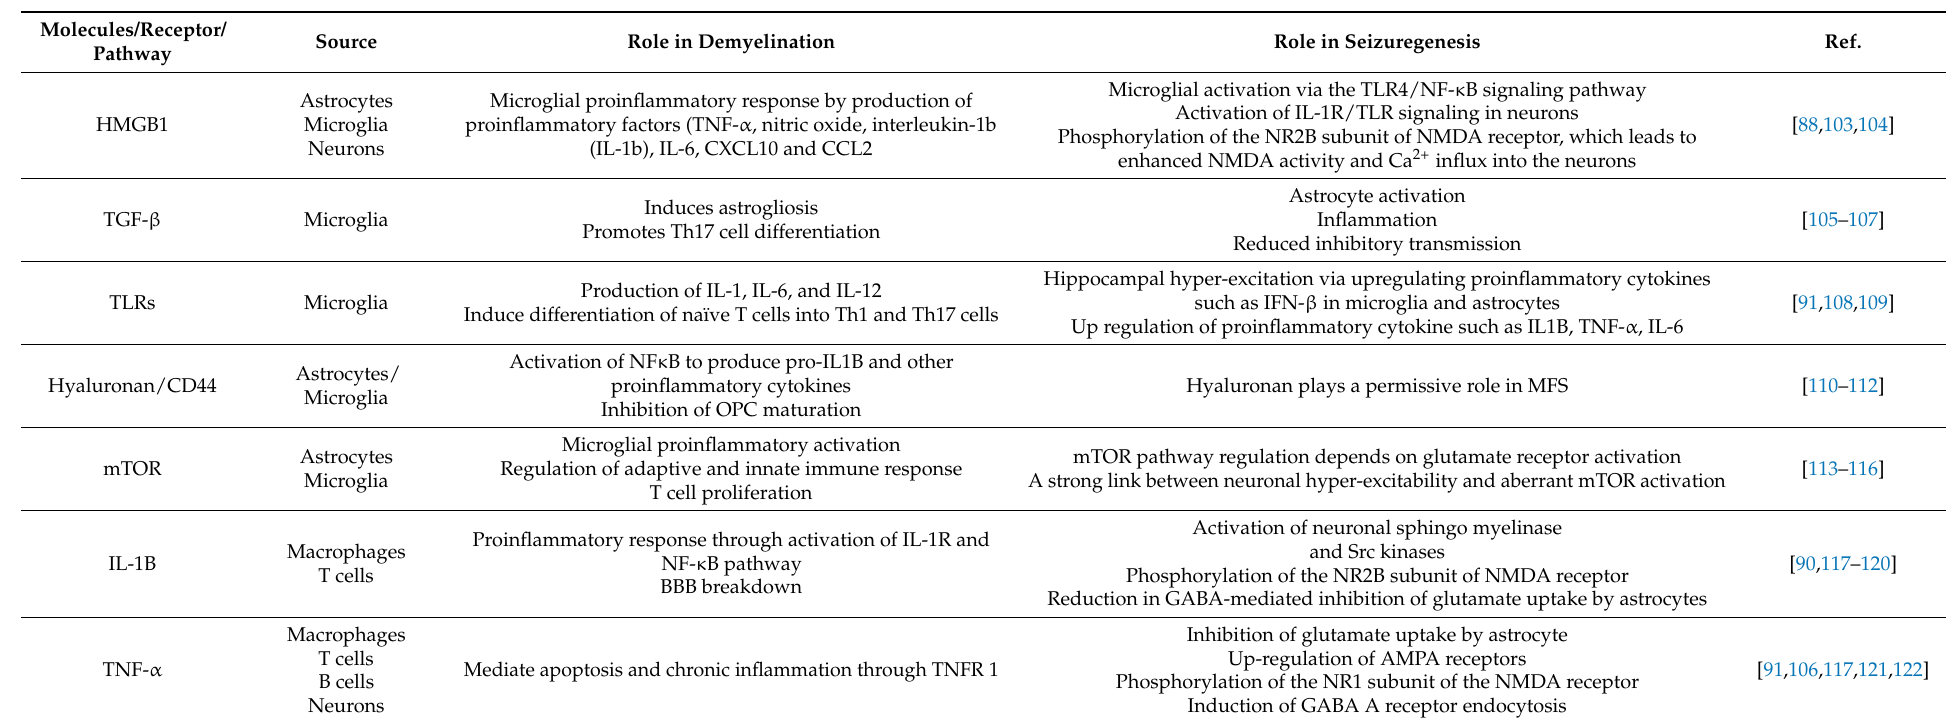
Table 3. Common inflammatory molecules/pathways underlying seizuregenesis and